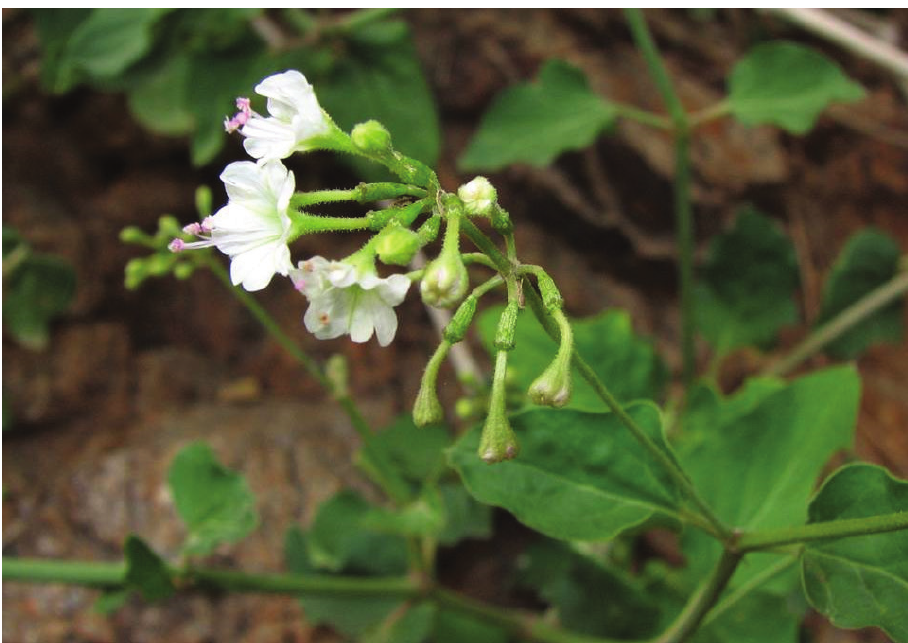
Figure 5. Flowers of Commicarpus plumbagineus in Sierra de Orihuela (Alicante, Spain). Photograph by L. Serra.